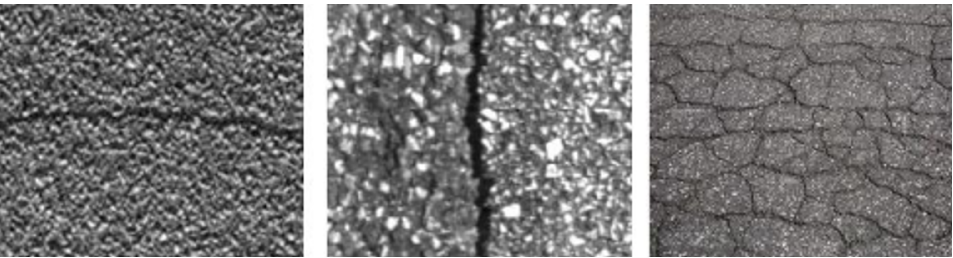
Figure 1. Some examples of real road